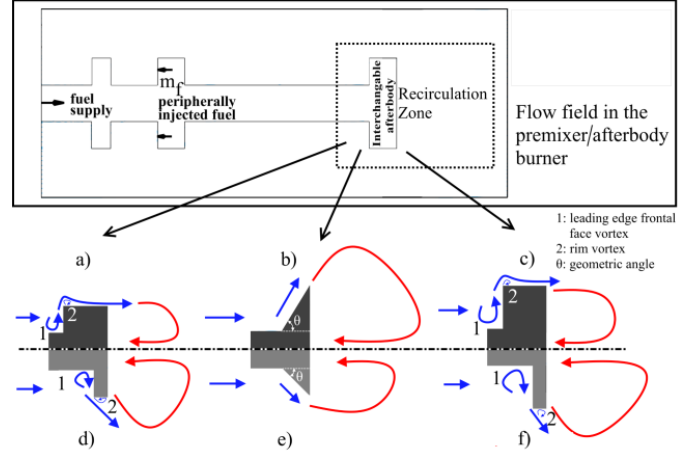
Figure 5. Flow disposition around selected bluff body configurations; ( a ) D-BR0.23-RIM3, ( b ) C- BR0.23-RIM2, ( c ) D-BR0.48-RIM3, ( d ) D-BR0.23-RIM1, ( e ) C-BR0.23-RIM2 and ( f ) D-BR0.48-RIM1.